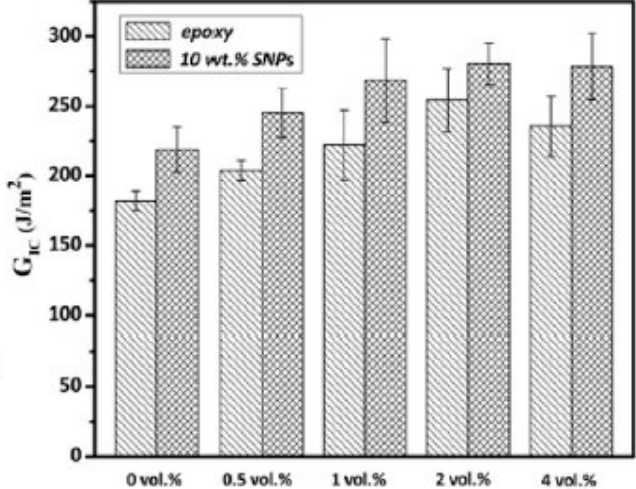
Figure 13. Fracture energy of silver nanowire-modified epoxy resin without and with 10 wt % nanosilica as a function of silver nanowire content [52].